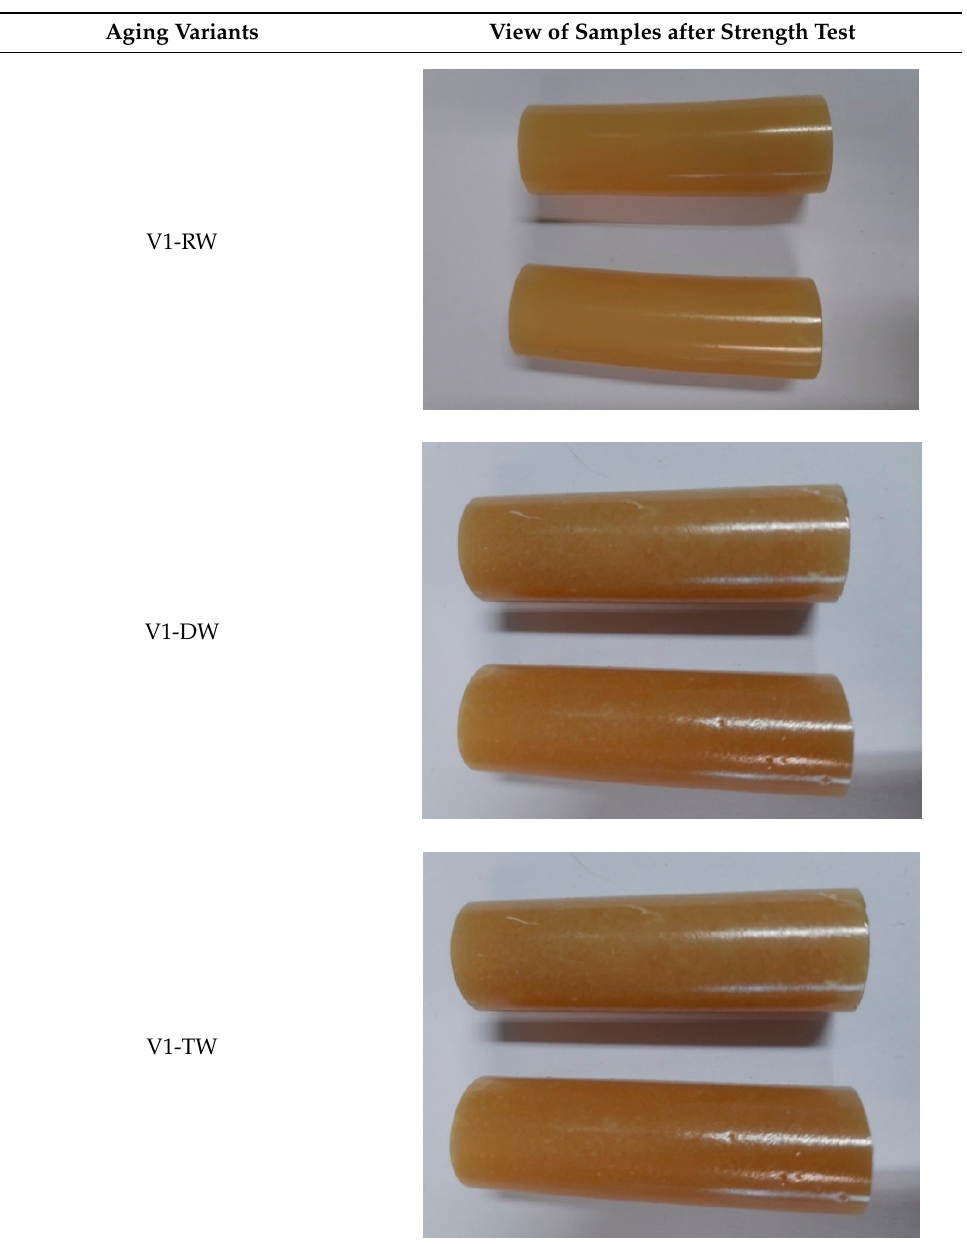
Table 8. View of the shape of the Epidian 57/PAC/1:1 epoxy compound samples—variant I.